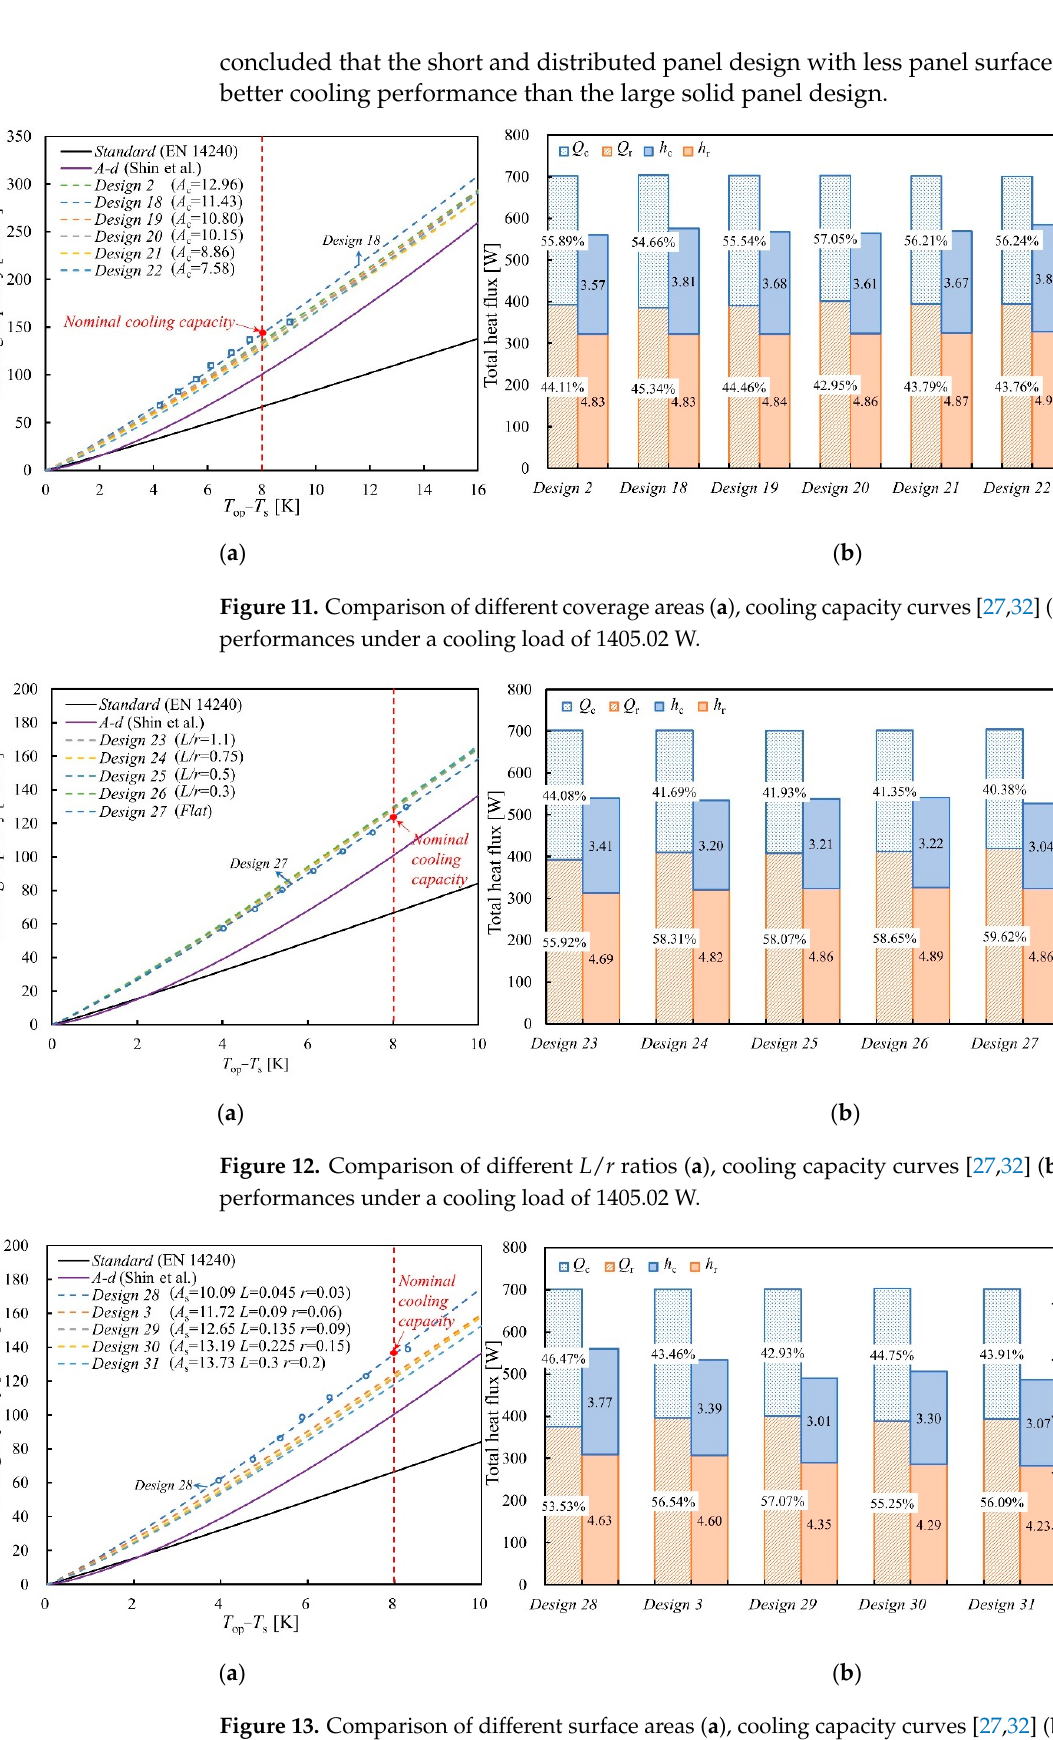
Figure 13. Comparison of different surface areas ( a ), cooling capacity curves [27,32] ( b ), and thermal performances under a cooling load of 1405.02